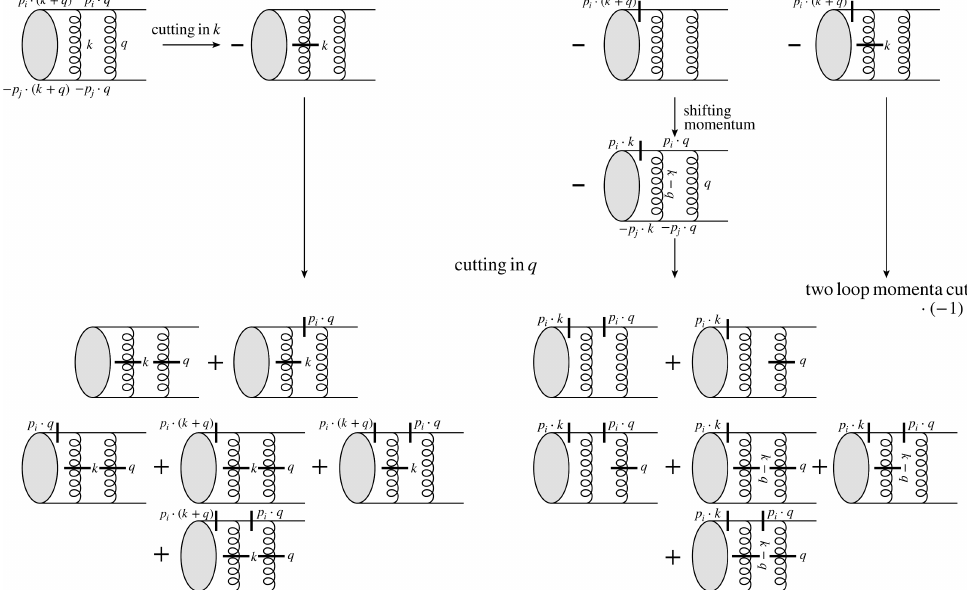
Figure 2 . Illustration of the workflow when applying the Feynman tree theorem at the two-loop level. The short black lines symbolise cuts of the corresponding propagators. We have explicitly included the negative sign due to the application of the FTT. The rightmost diagram in the top row obtained by the FTT in the momentum k appears in the cutting procedure in total three times (twice with a positive sign, one with a negative sign). Due to this cancellation the diagram is drawn only once in the first line, we have to multiply by ( − 1) in order to find the final result. Modulo this convention each arrow indicates